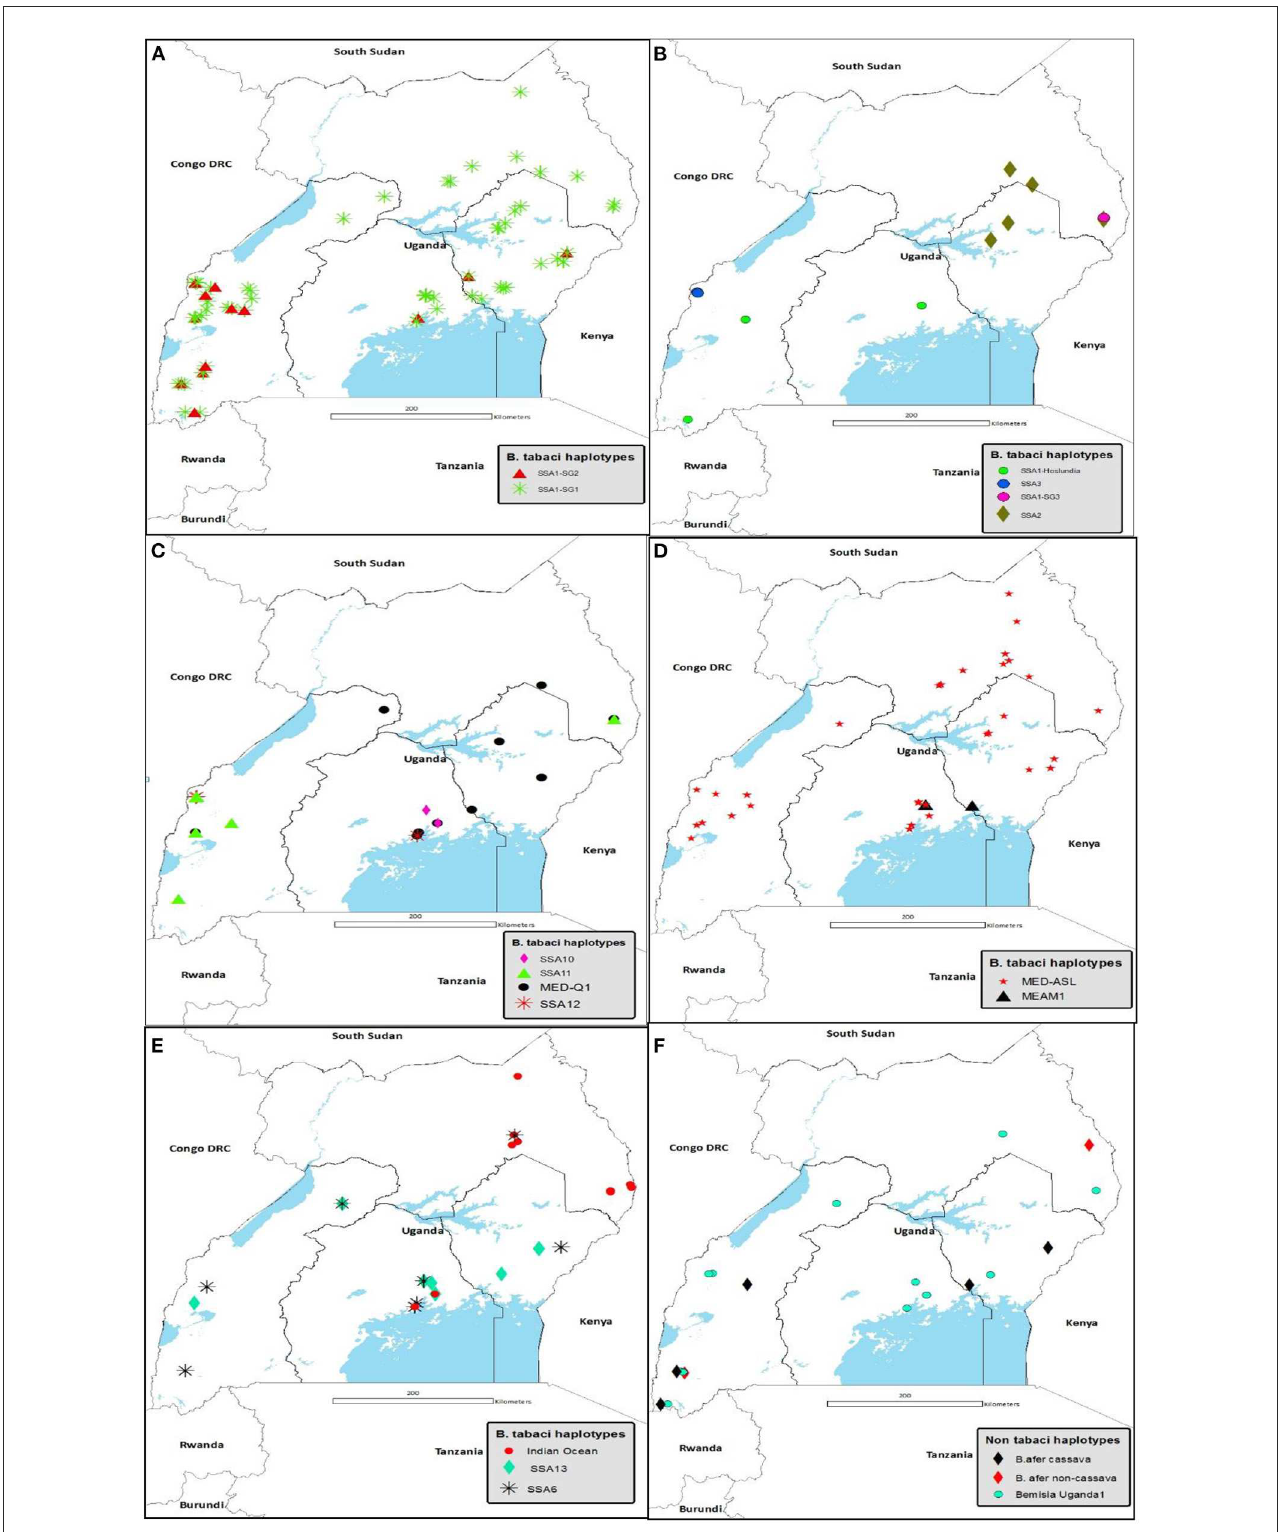
FIGURE4 Agro-ecological distribution of (A) SSA1-SG1 and SSA1-SG2: (B) SSA1-Hoslundia, SSA1-SG3, SSA2 and SSA3: (C) SSA10, SSA11, SSA12 and MED-Q1: (D) MED-ASL and MEAM1: (E) SSA6, SSA13 and Indian Ocean: and (F) B. afer and Bemisia Uganda1 species collected in Uganda during May/August 2017. Abbreviations for the B. tabaci species: SSA, sub-Saharan Africa; SG, sub-group; MED, Mediterranean; ASL, African silver leafing and MEAM1, Middle East-Asia